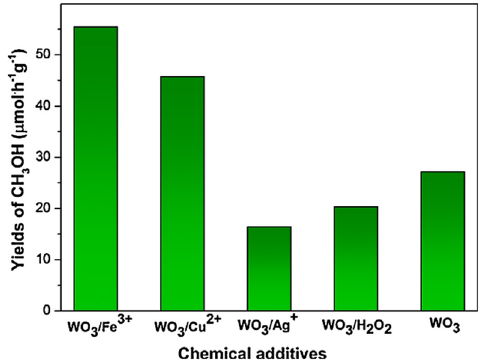
Figure 26. Yields of CH 3 OH in the photocatalytic oxidation of CH 4 in systems of different electron scavengers [88]. Reproduced with permission from Villa et al. Copyright © 2022